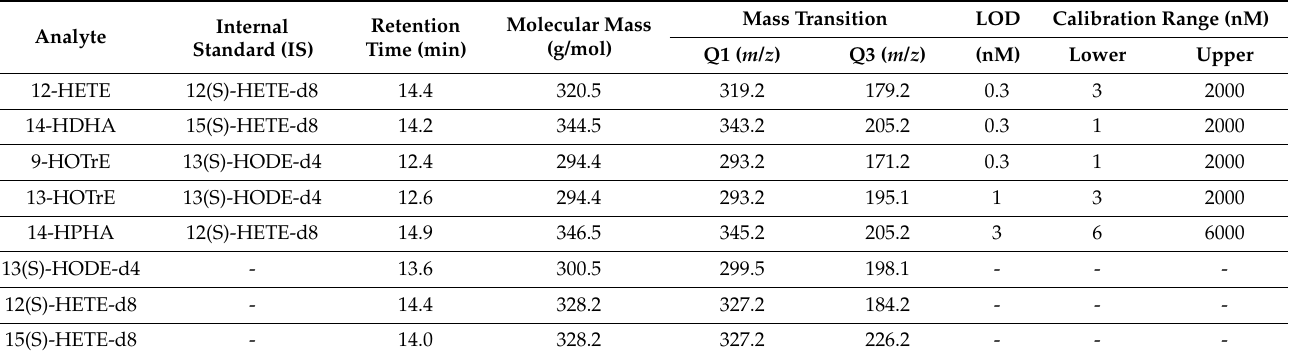
Table 1. LC/MS/MS analyses of targeted